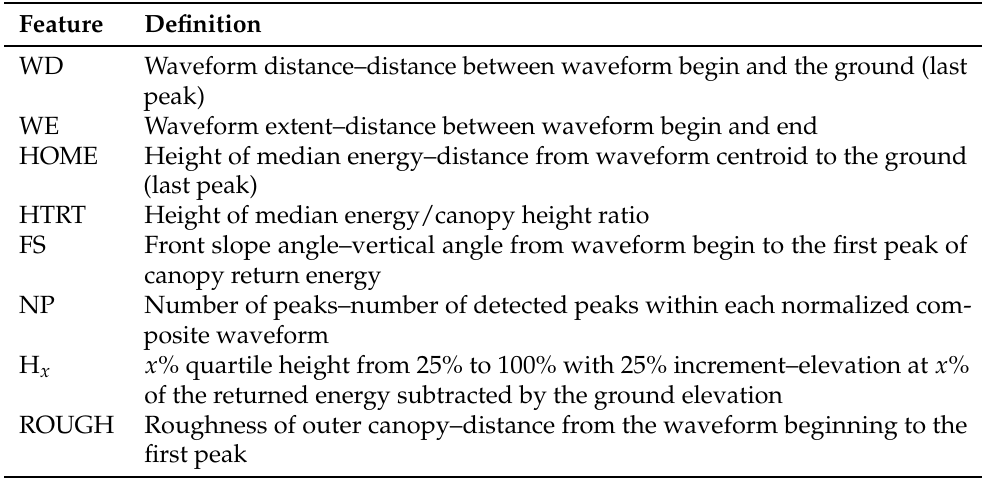
Table 4. Single waveform LiDAR